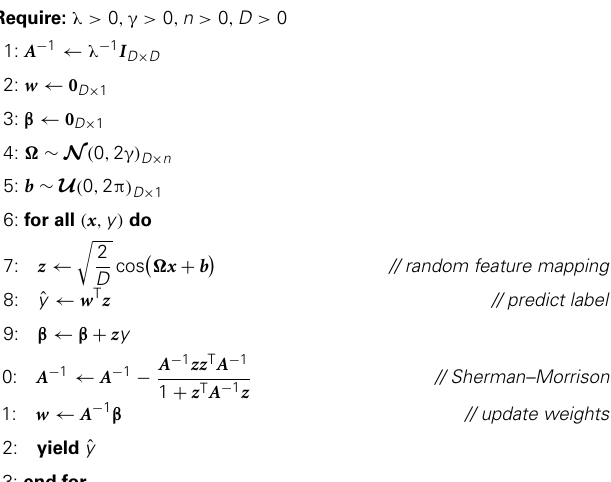
Algorithm 1 | Incremental Ridge Regression with RBF Random Fourier